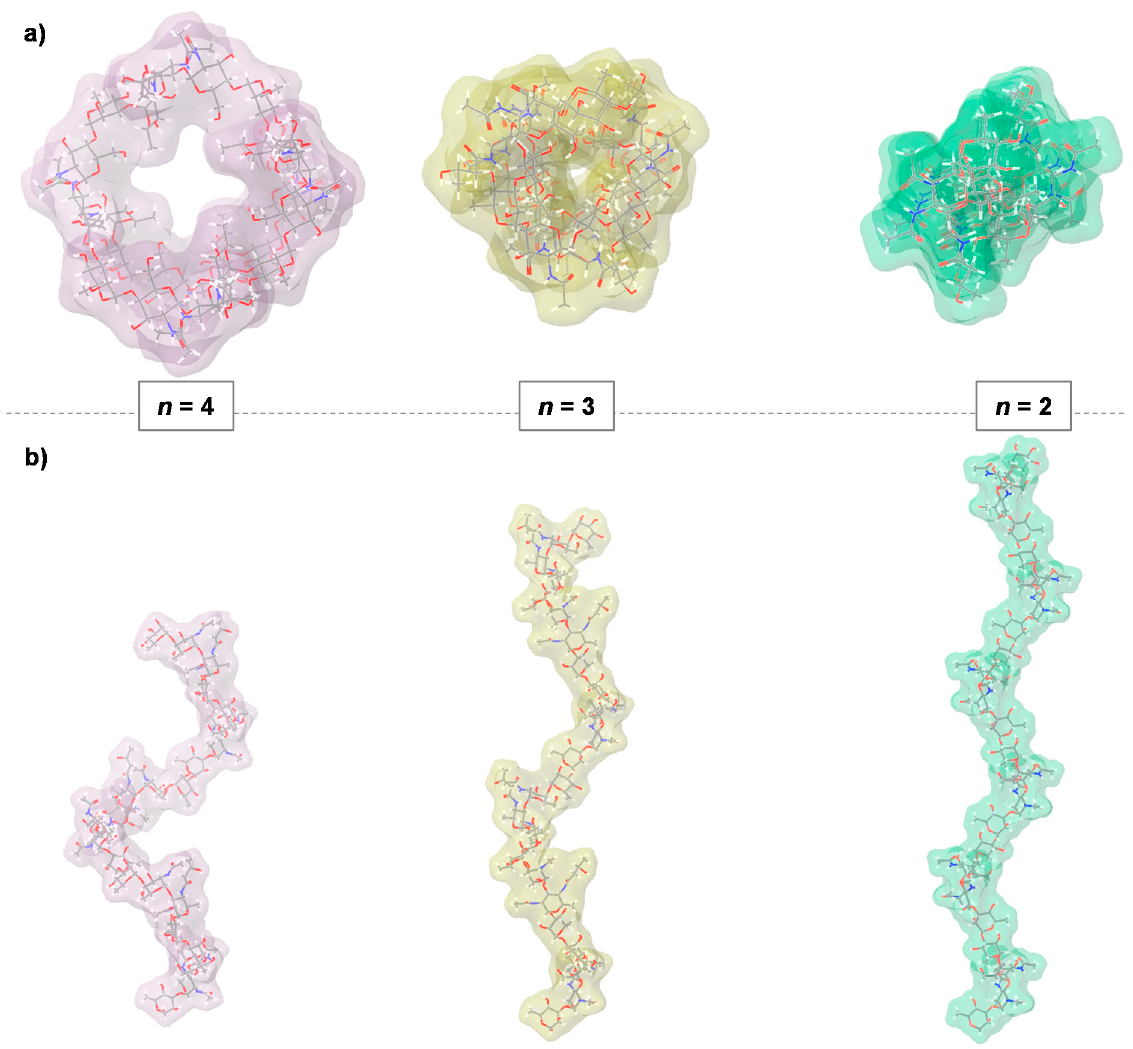
Figure 3. Conformational analysis of the O-antigen of C. metallidurans CH34. ( a ) Top view evidencing the symmetry of the three helices; ( b ) Lateral view. The O-antigen assumed a right-handed helix conformation with a certain number of repeating units for the turn of helix: n = 2 (light green), n = 3 (light yellow), or n = 4 (light pink). The axial rise per repeating unit is of 9.1, 12.6 and 14.0 Å, for n = 4, 3 and 2, respectively.